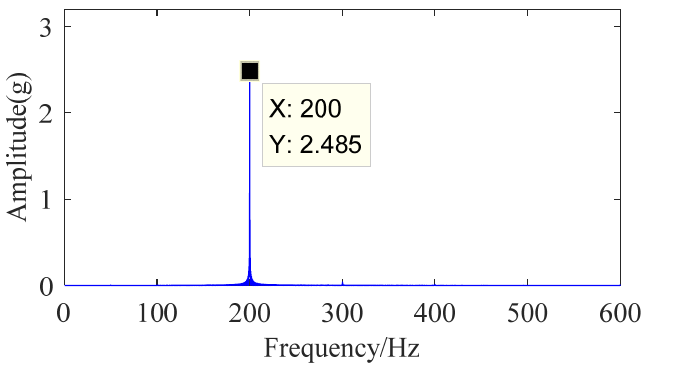
Figure 18. Vibration response of galvanized iron clamp with a 200- µ m-thick hard coating of Al-Cu- Fe-Cr under 200 Hz fixed-frequency excitation.